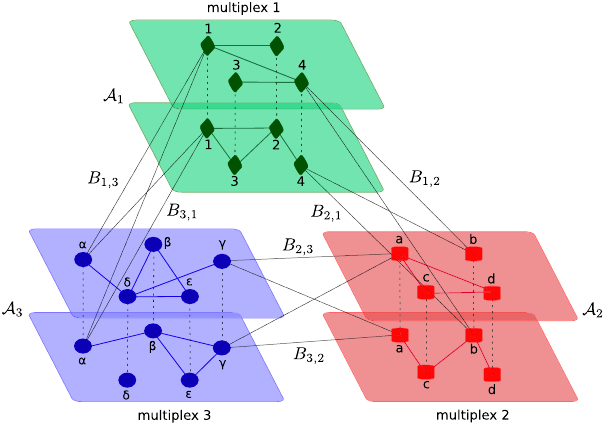
Fig. 1 A universal multilayer network. A universal multilayer network composed of three multiplex networks (green, blue and red multiplex networks). Each multiplex network contains different types of nodes (denoted 1 to 4, α to ϵ , and a to d, respectively). Their corresponding Supra- adjacency matrices are denoted by A i . The three multiplex networks are linked by six bipartite networks (represented here as bipartite interactions for the sake of visualization). The corresponding Bipartite network matrices are denoted by B i , j . It is to note that a connection between a node i in a fi rst multiplex network and α and a node j in a second multiplex network β imposes the creation of edges between all replicas of node i present in the different layers of the multiplex network α and all replicas of node j present in the different layers of multiplex network β . All the edges of the universal multilayer networks can be weighted and/or